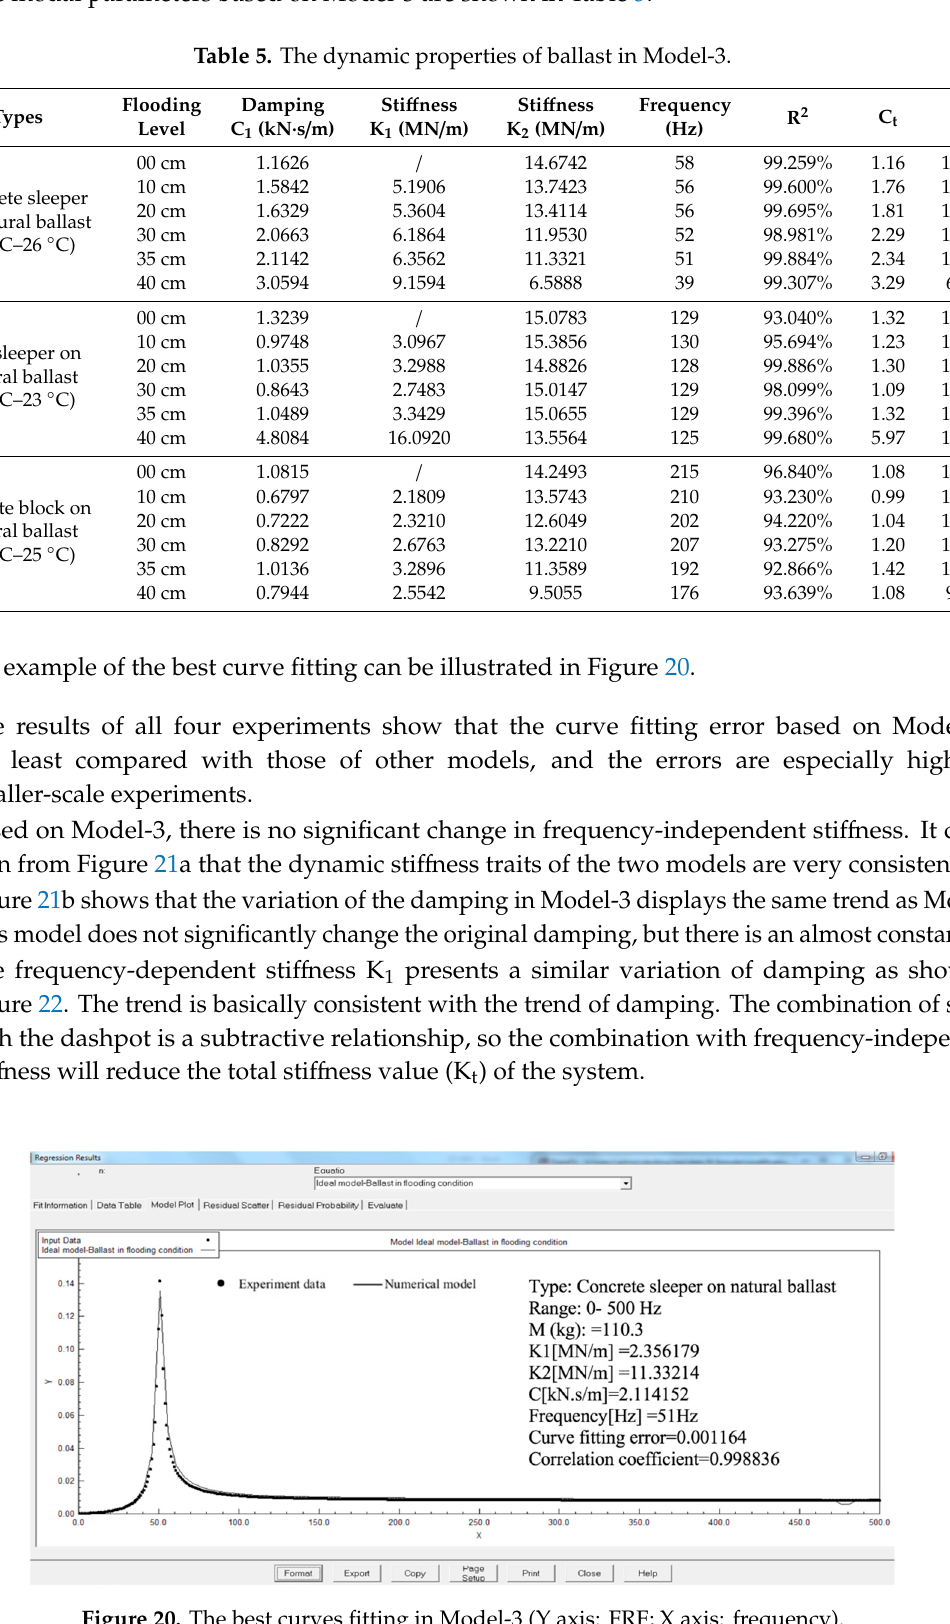
Table 5. The dynamic properties of ballast in Model-3.